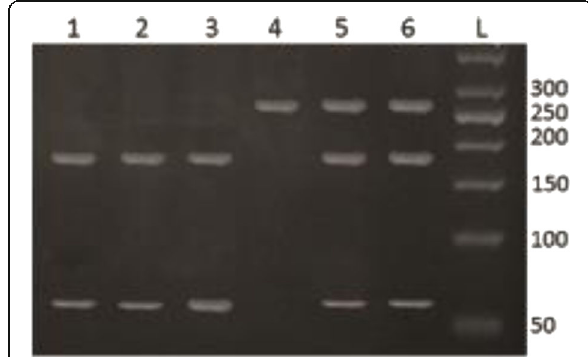
Fig. 1 Agarose gel electrophoresis of GSTO1*A140D (rs4925) SNP RPFP-PCR products. Lanes 1, 2, and 3: homozygous wild genotype C/C (186 bp, 68 bp). Lane 4: homozygous mutant genotype A/A (254 bp). Lanes 5 and 6: heterozygous mutant genotype C/A